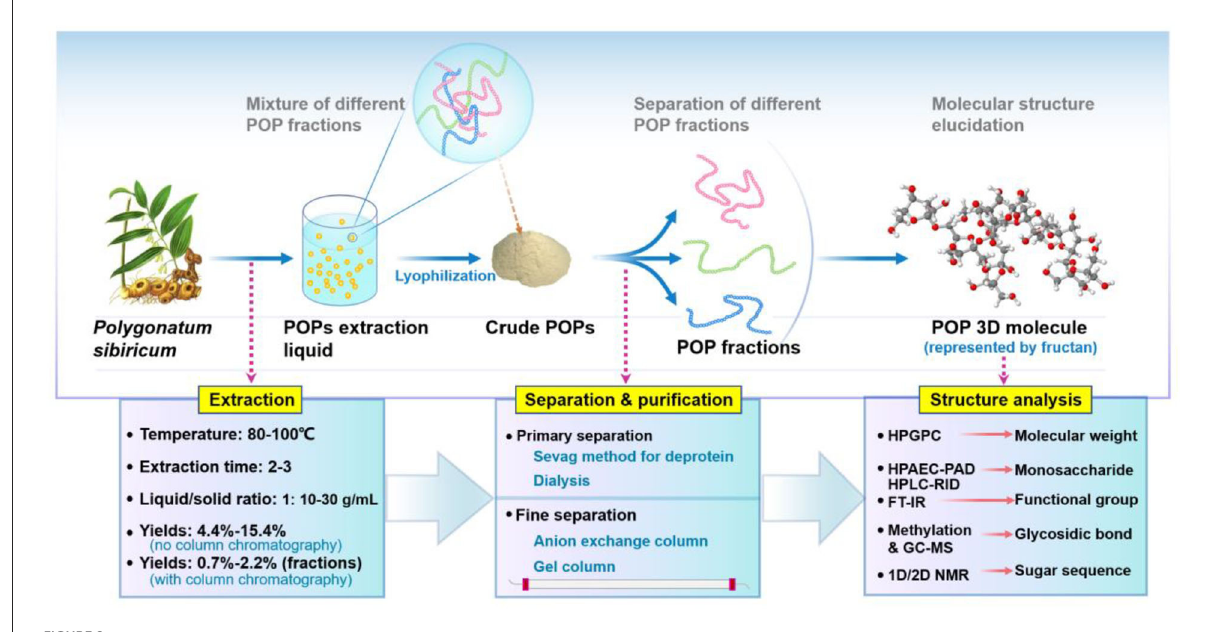
FIGURE2 Overall presentation of extraction, purification, and structure analysis of